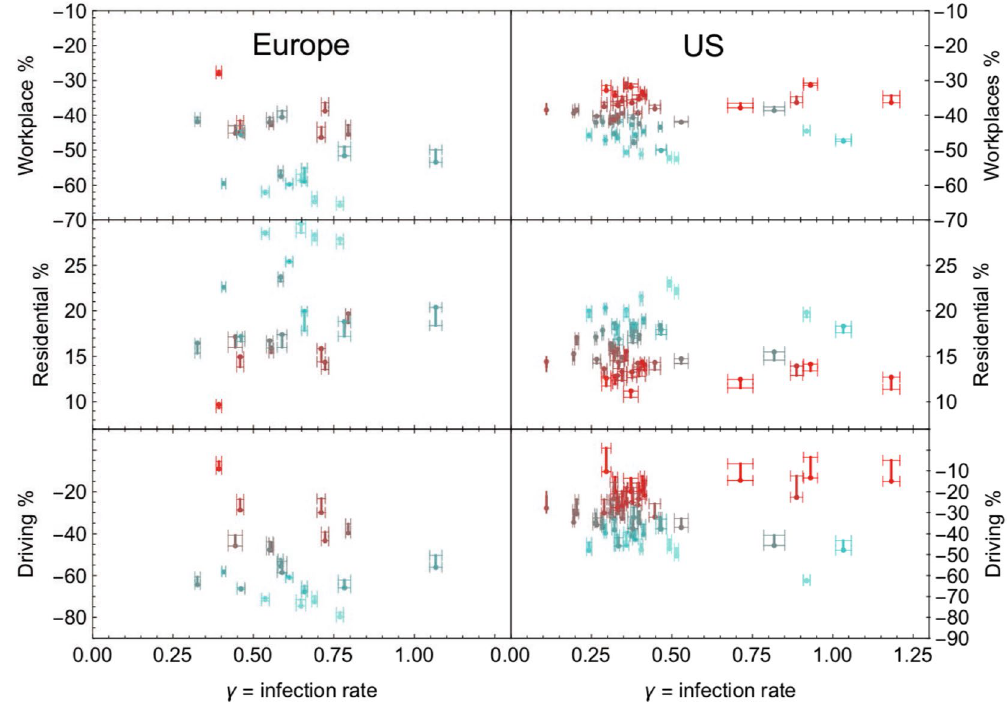
Figure 4. Infection rate compared to the mobility data. Racecar plots showing the fitted infection rates γ versus the Google/Apple mobility categories. The vertical segment indicates the difference between 6 week (dot) and 8 week averages; the horizontal bars indicate the fit error on γ